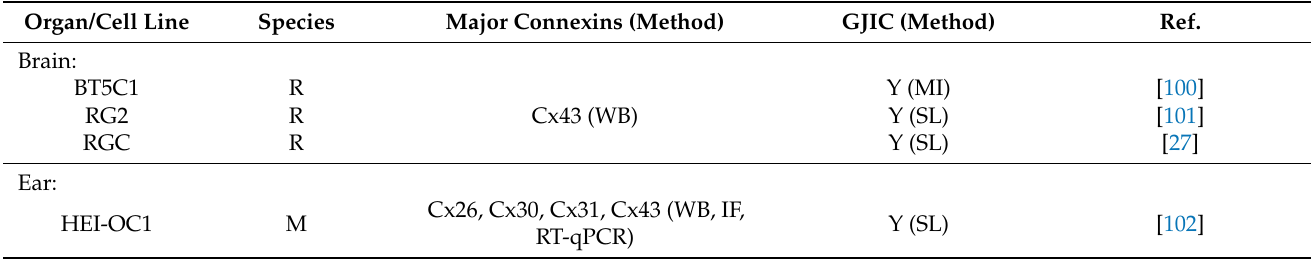
Table 1. Overview of cell lines commonly utilized for GJIC assessment with major studied connexins (Cx) and used